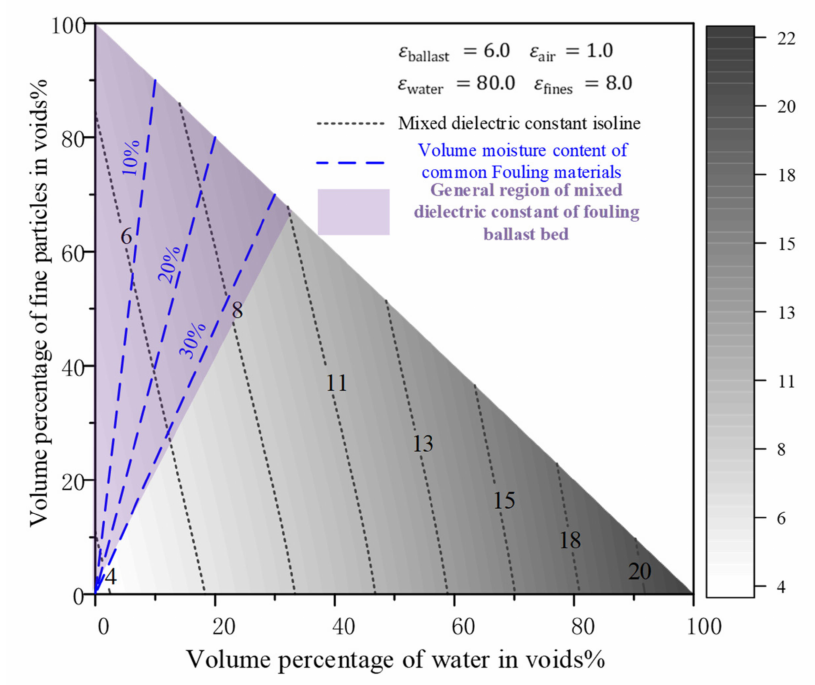
Figure 5. Distribution of dielectric constants for ballast layers at different fouling